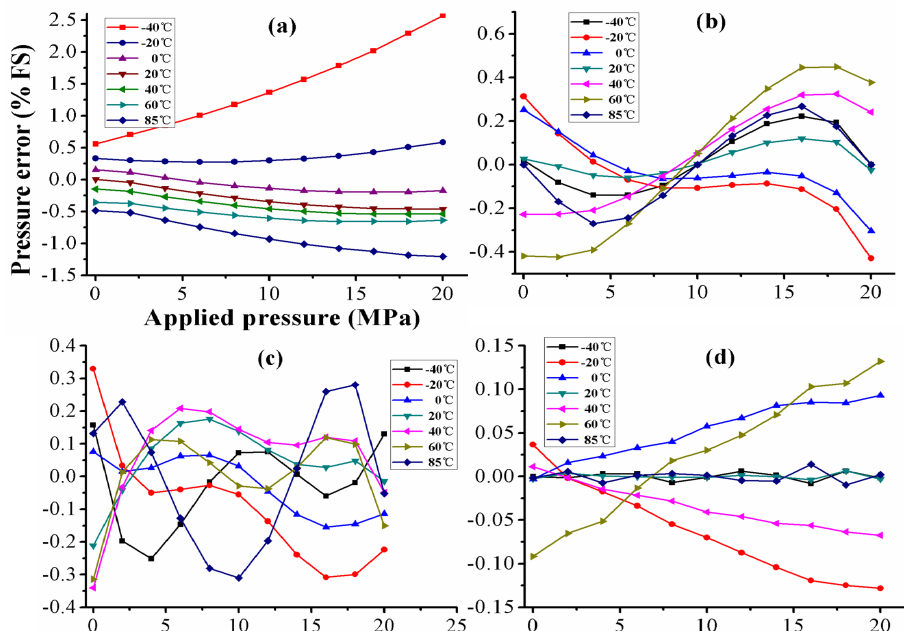
Figure 12. Compensated pressure errors of ELM: ( a ) before and ( b ) after compensation using 3 × 3 calibration; ( c ) after compensation using 4 × 6 calibration; ( d ) after compensation using 5 × 11